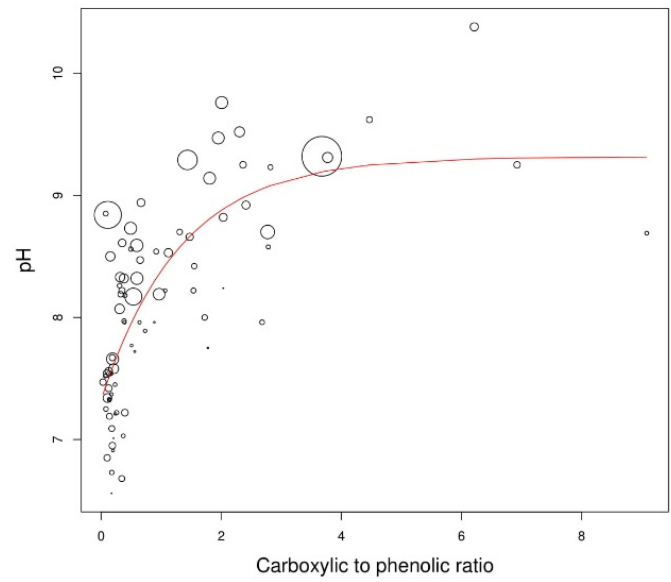
Figure 5. Biochar pH prediction using a non-linear model as a function of char chemistry in 84 slow-pyrolysis wood biochars. The size of points is proportional to the summed concentrations of Ca and K in samples. The fitted equation shown is a non-linear model (Equation (1)), setting Ca and K equal to mean values in the sample.